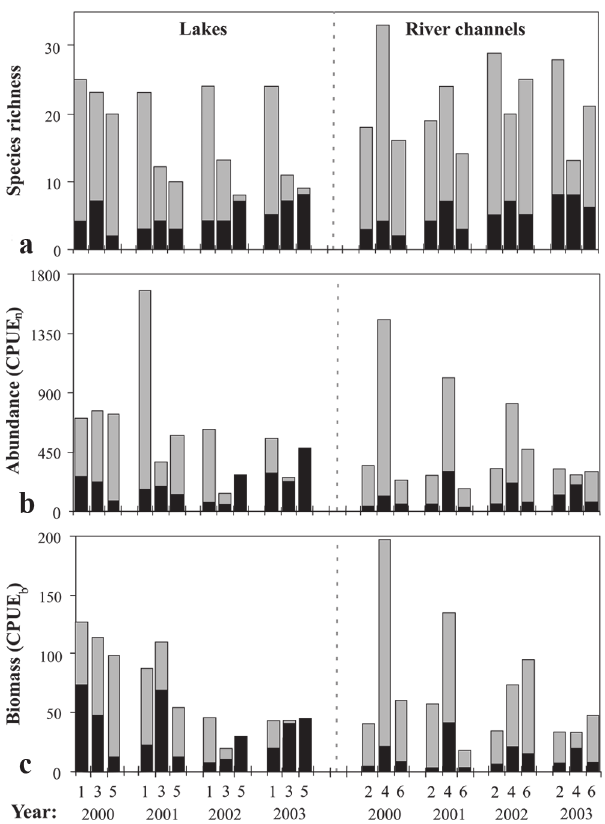
Fig. 5. Fish assemblage attributes in the main habitats of the upper Paraná River floodplain in years of short (2000 and 2001) and moderate (2002 and 2003) floods. The black area of the bars represents the proportion of STH. Numbers 1-6 on the abscissa are codes of the sampling stations (see Fig.